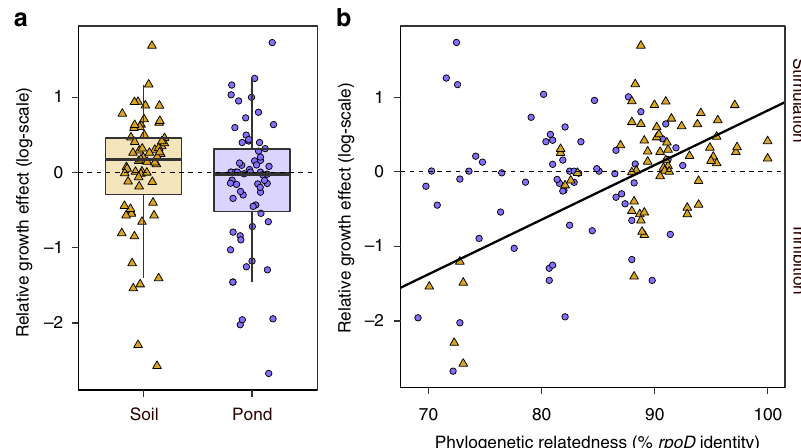
Fig. 3 Foreign supernatants containing pyoverdine can have stimulatory, neutral or inhibitory effects on the growth of receiver strains. Supernatants containing pyoverdine from donor strains were fed to receiver strains from the same community, which produced lower amounts of pyoverdine than the donors. a The growth effect of foreign supernatants on receivers varied on a continuum from high inhibition to high stimulation. The average growth effect of donor supernatants on receivers did not signi fi cantly differ between soil ( yellow triangles , n = 63 strain combinations) and pond ( purple circles , n = 62) isolates. Box plots depict median, fi rst and third quartile, and the 95% con fi dence interval. b There was a signi fi cant positive correlation ( solid black line , linear mixed model: t 38 = 5.32, p < 0.001) between the rpoD identity (i.e. relatedness) of receiver – donor pairs and the supernatant growth effect for soil, but not for pond isolates. The dashed line depicts neutral effects, whereas values greater or smaller than zero indicate cases of stimulation or inhibition, respectively, relative to conditions where receivers grew without donor supernatant. Data were ln-transformed prior to